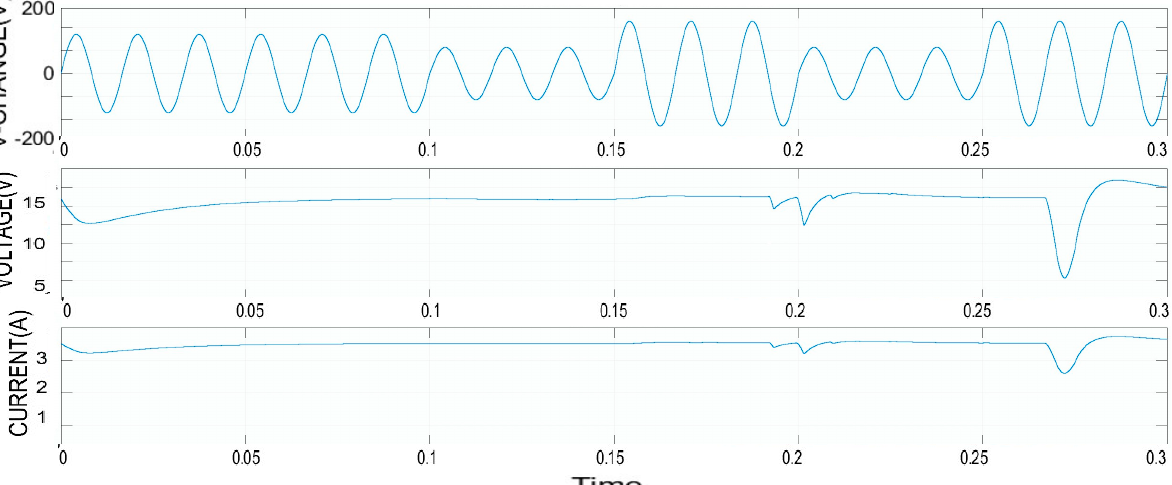
Figure 14. Closed-loop single-level simulation results.